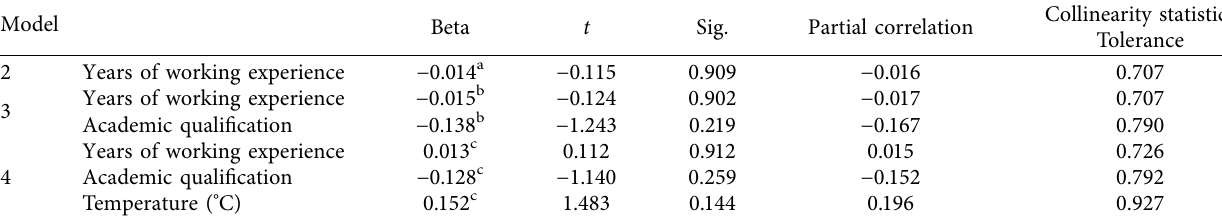
Table 7: Excluded